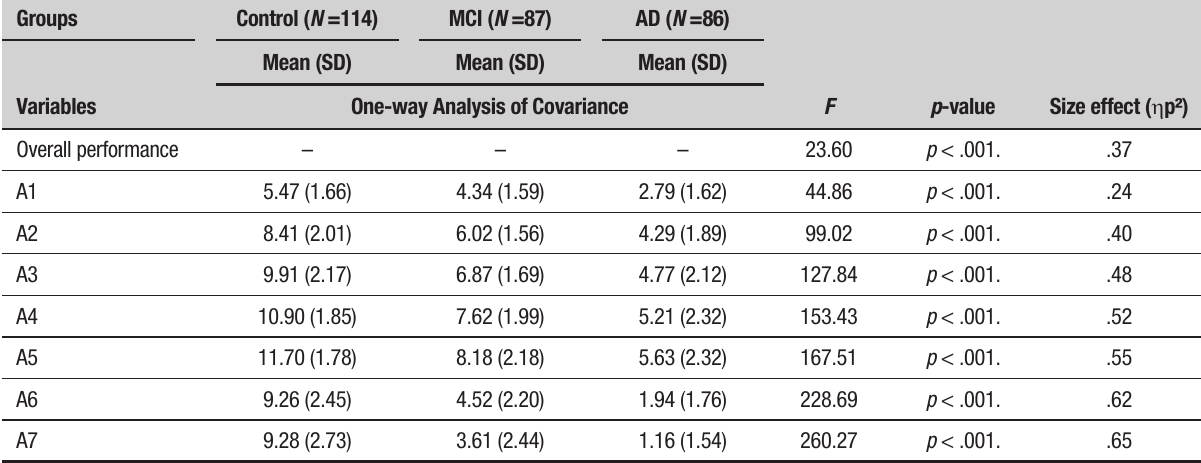
Table 2. MANCOVA and ANCOVA results for group effects and comparison of performance across trials between groups. Groups